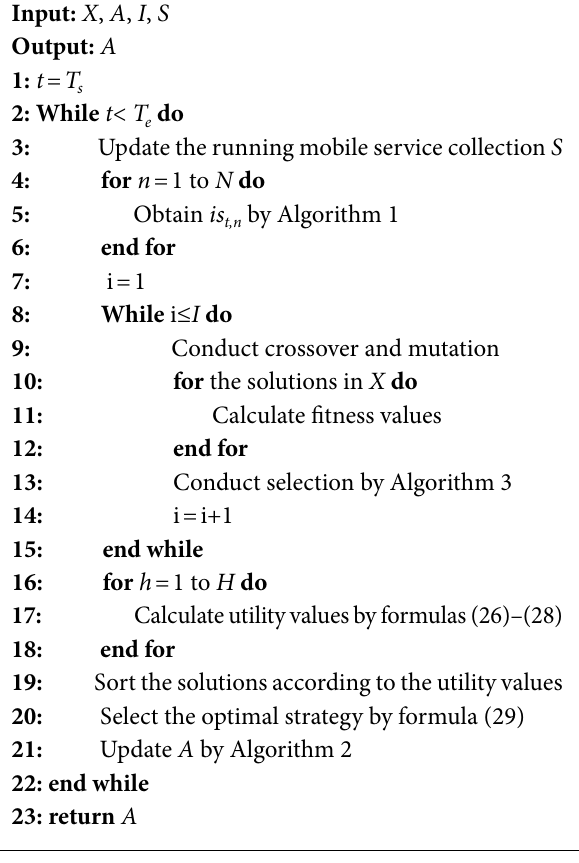
Algorithm 4: Balanced resource scheduling method